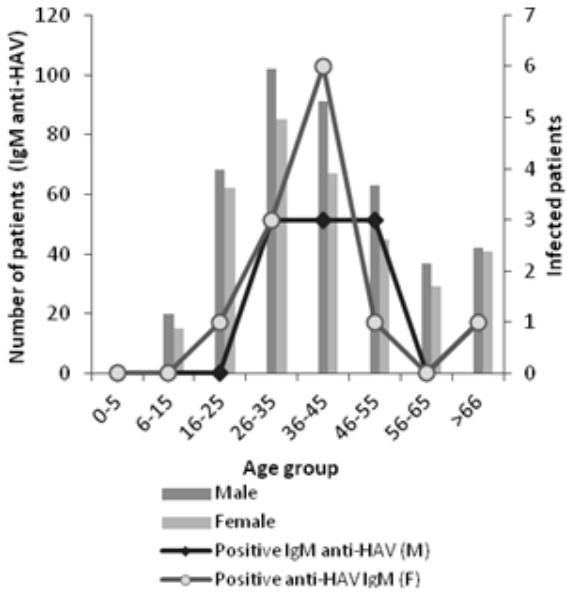
Figure 5. Number of infected patients by gender and age